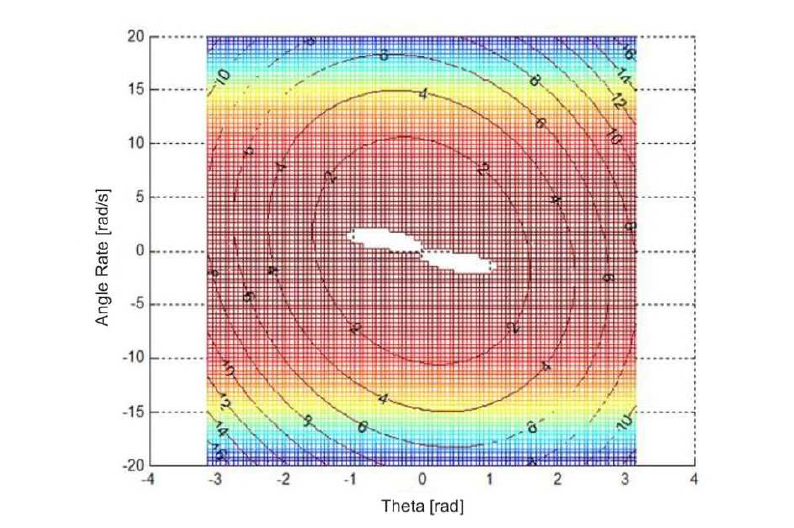
Figure 2. V ( x ) and ˙ V ( x ) in the roll